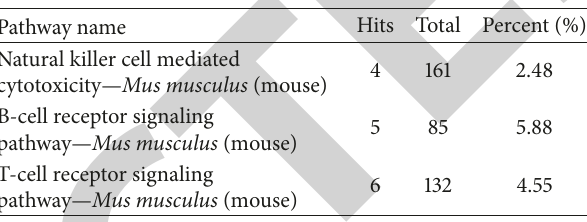
Table 2: Pathways of upregulated genes.